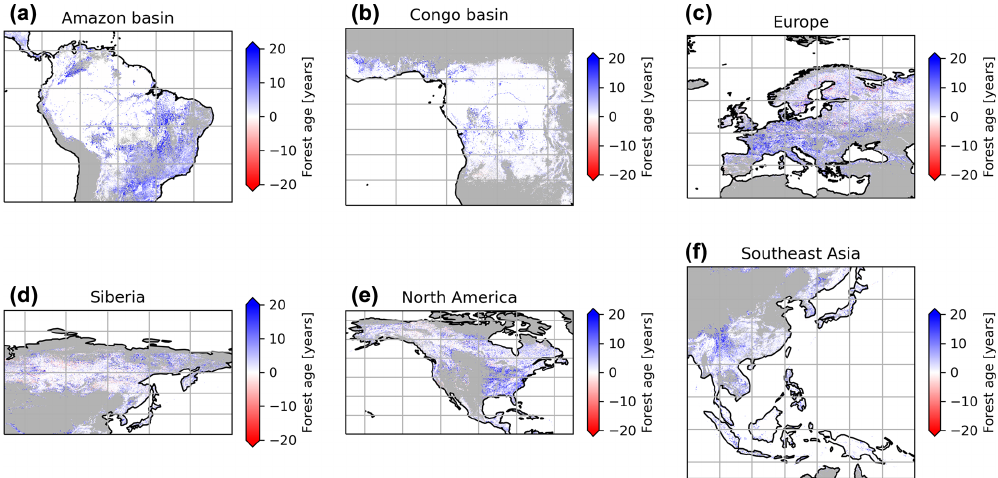
Figure 8. Sensitivity of the presented age product using 30% tree cover correction thresholds or no tree cover correction. The differences between the age estimates derived from a forest biomass product using a 30% tree cover correction and the age estimates derived from a forest biomass product not using a tree cover correction are shown. The blue colour means that the age estimates are higher with the 30% tree cover correction than without correction, while the red colour means that the age estimates are lower with the 30% tree cover correction than without correction.